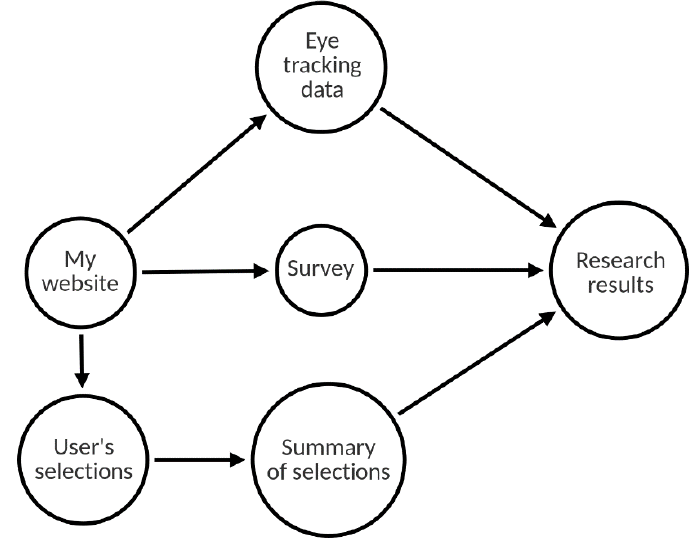
Figure 1. Experimental design summary. Source: own elaboration.